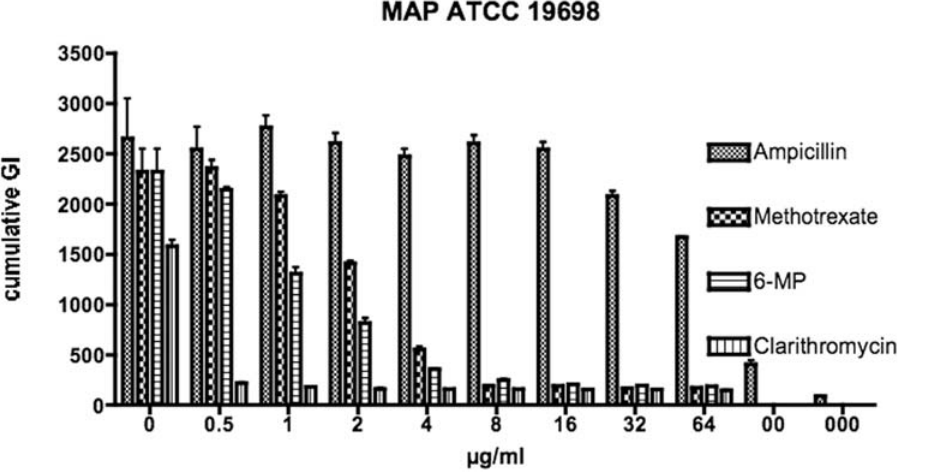
Figure 1. Shown is a bar graph of the cumulative GI data evaluating MAP ATCC 19698. Each drug dilution was studied in duplicate. Error bars are SD. There are three control inoculations, labeled on the abscissa as ‘‘0, 00 & 000. The left hand ‘‘0’’ had an equal number of CFU’s as in each drug studied. ‘‘00’’ = 10 & ‘‘000’’ = 100 fold dilutions. In each control the maximum concentration of diluent used for each agent (methanol for Clarithromycin, water for ampicillin and NaOH for methotrexate and 6-MP) was added. Clarithromycin is most effective and ampicillin is the least effective at decreasing MAP growth. Both methotrexate and 6-MP are as effective as clarithromycin in MAP % 2 D cGI at a dose of 4 m g/ml. doi:10.1371/journal.pone.0000161.g001 PLoS ONE |